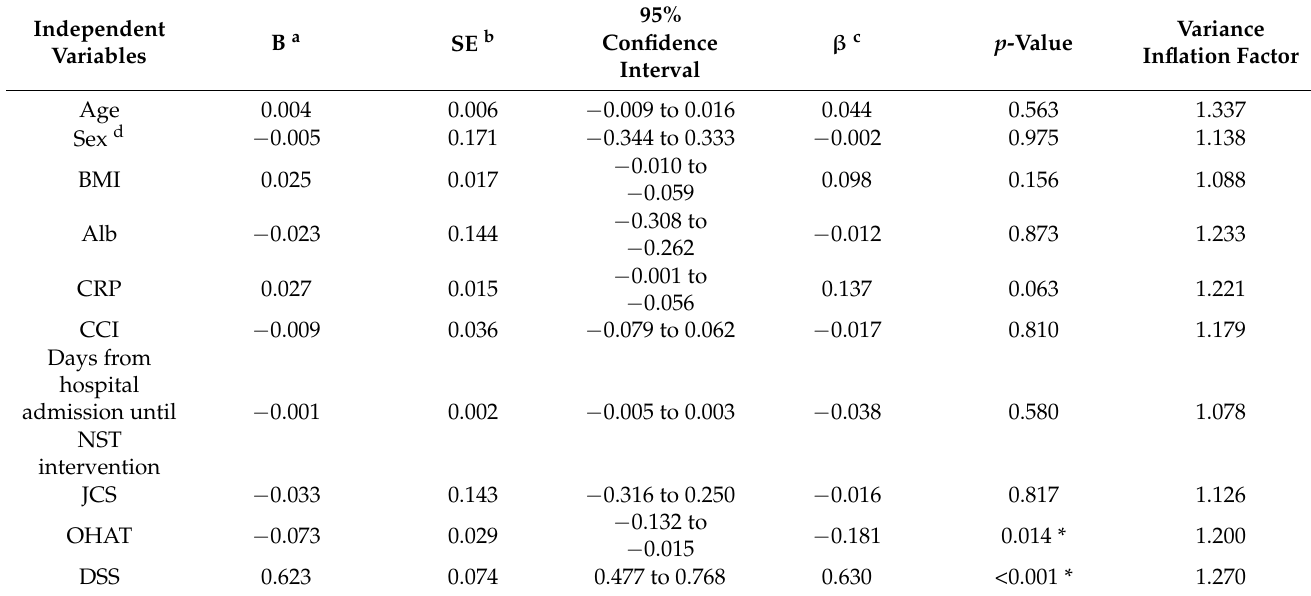
Table 4. Multiple regression analysis using FOIS-R as the objective variable in participants with FOIS-R 3–7 ( n =